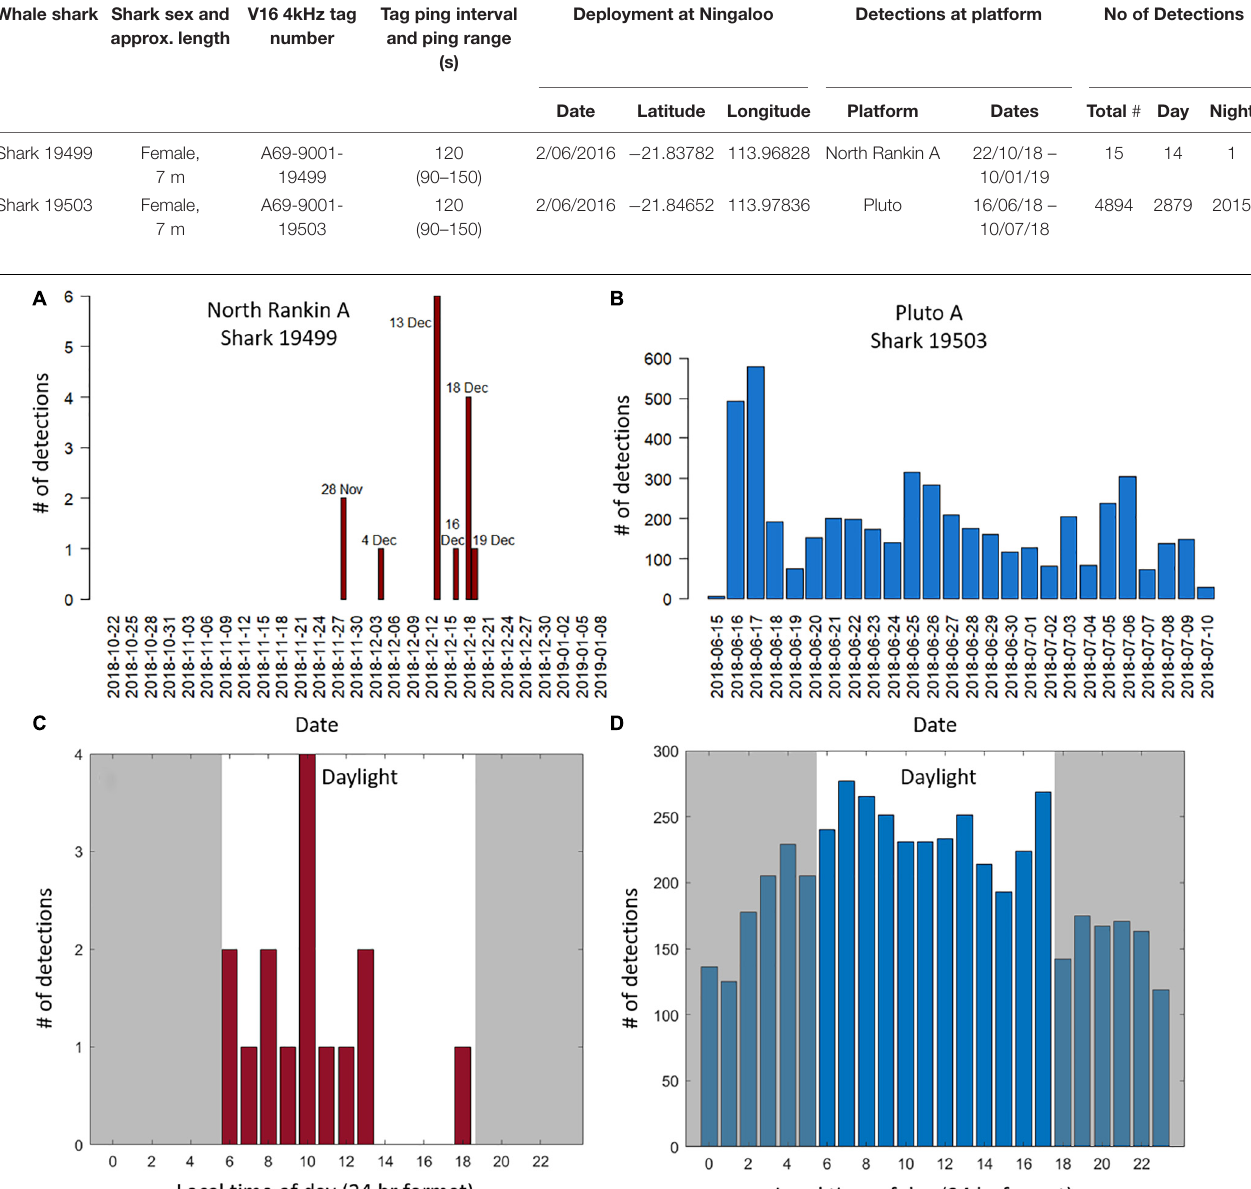
TABLE 1 | Deployment and detection details for the V16 69 kHz acoustic transmitters deployed on whale sharks at Ningaloo Reef and detected at the oil and gas platforms on the North West Shelf. Whale shark Shark sex and V16 4kHz tag approx. length number